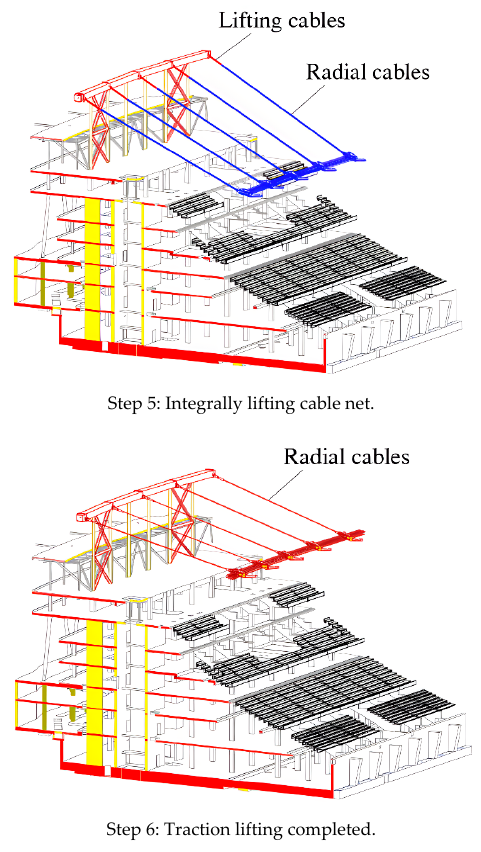
Figure 24. Schematic diagram of cumulative sectional traction lifting. According to the adjusted traction lifting sequence, the analysis is divided into 11 calculation conditions, as shown in Table 10. The lengths of traction cables under each calculation condition are shown in Table 11 (quarter symmetry of structure). Table 10. Calculation conditions during cumulative sectional traction lifting.